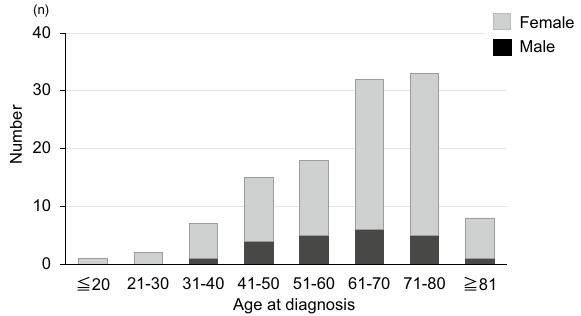
Figure 1. Age distribution of cases by gender.